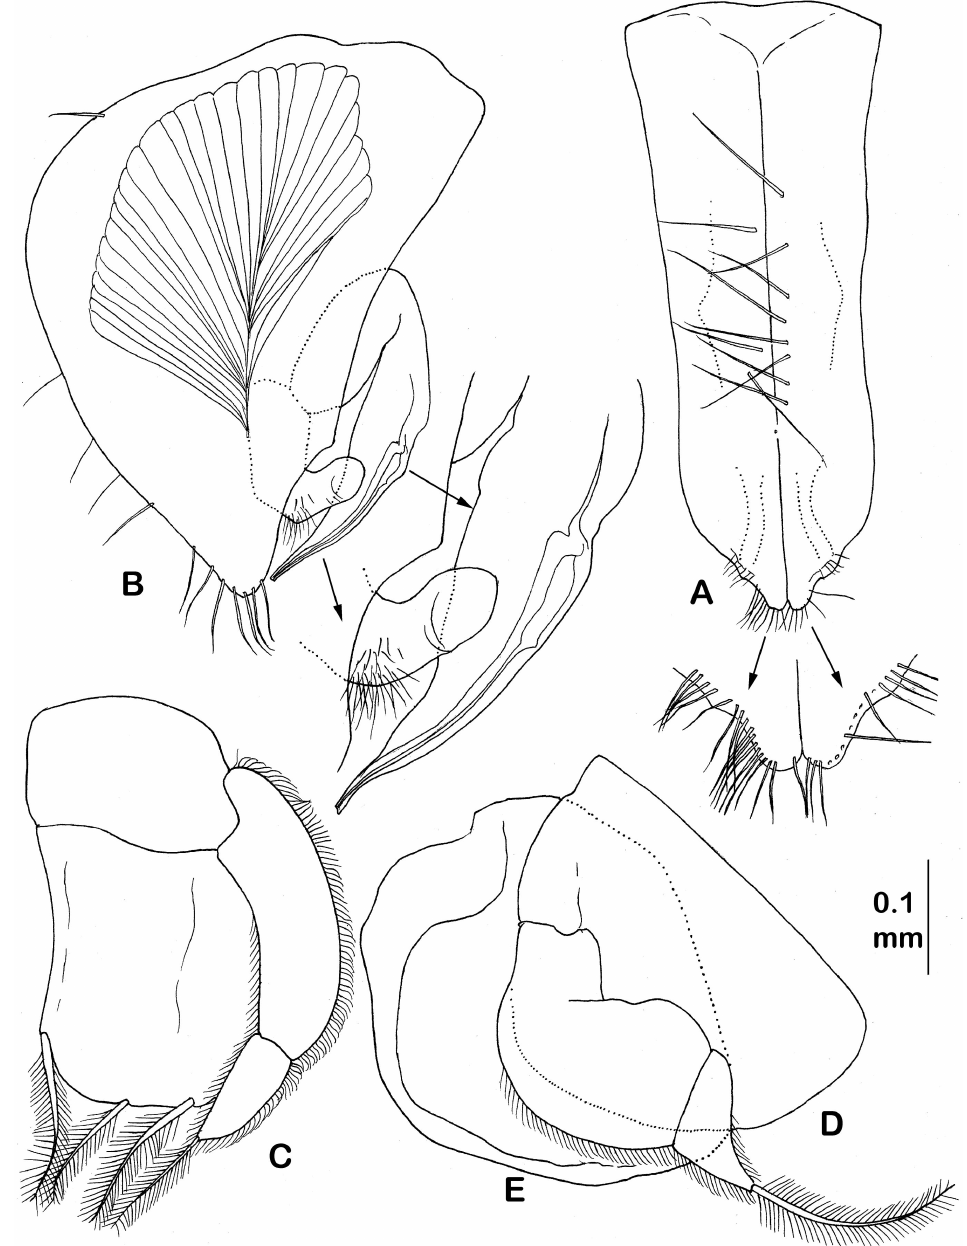
Figure 30. Eurycope emmae sp. nov. Male holotype (ZMH K-45652): ( A ) pleopod I (distal margin en- larged); ( B ) pleopod II (distomedial margin enlarged); ( C ) pleopod III; ( D ) pleopod IV; ( E ) pleopod V. 3.8. Eurycope jakobi Schnurr & Malyutina sp. nov. http://zoobank.org/2F7AD002-ECC6-4871-95CB-184ADC9B33A9 (accessed on 3 June